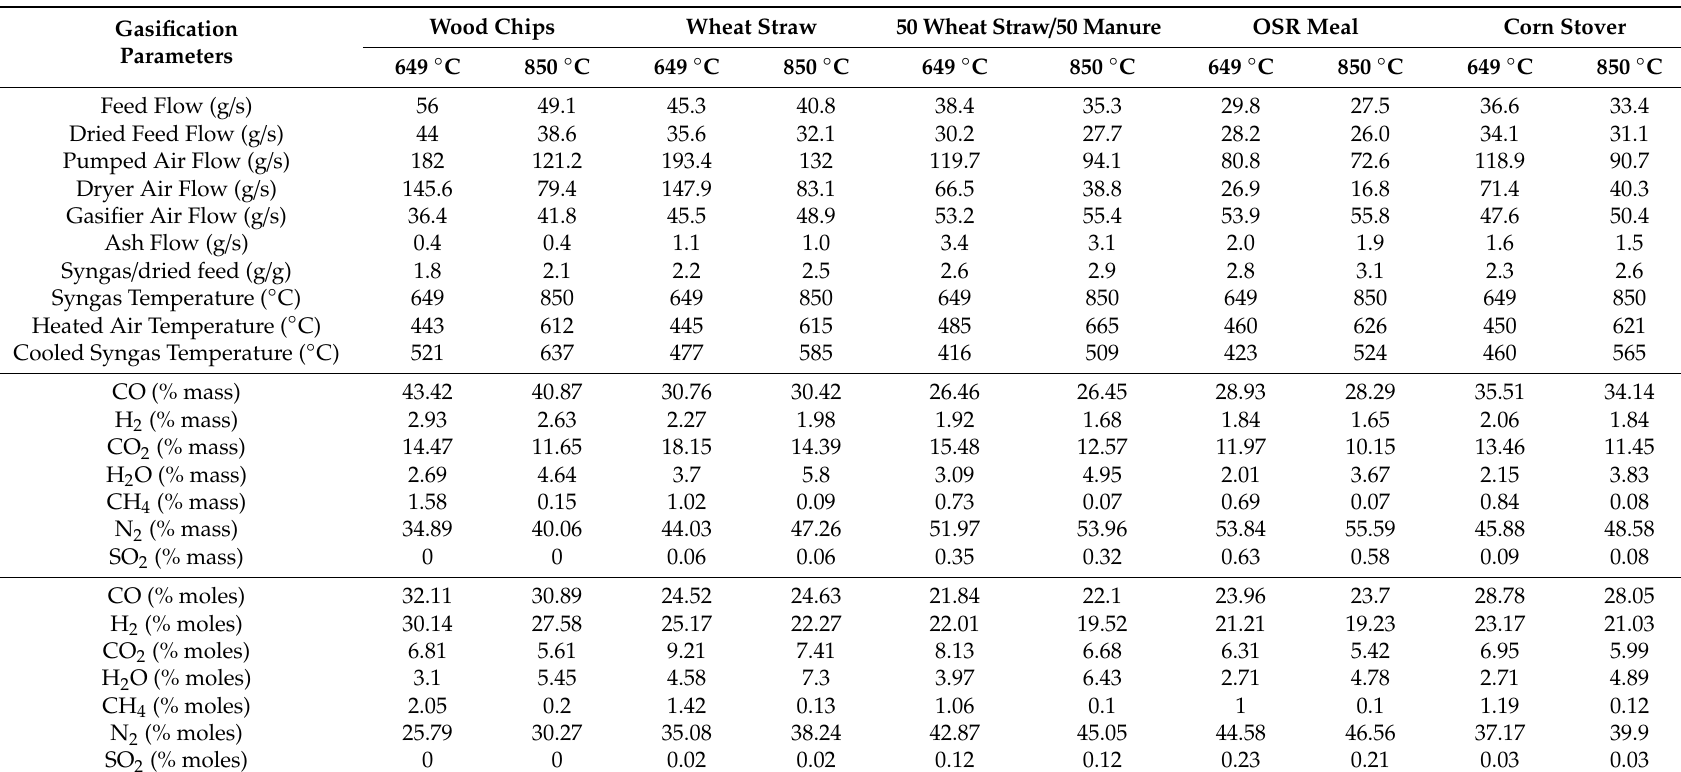
Table 4. Mass flow, temperatures, and syngas composition of gasification simulation, all referenced to syngas flow rate of 80 g /